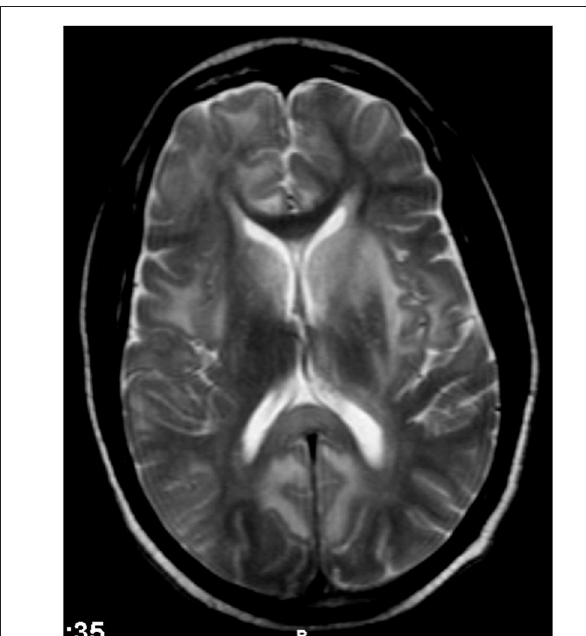
FIGURE 1 | Case 12: Brain MR imaging (axial T2-weighted image) demonstrating multiple confluent white matter hyperintensities. There are significant hyperintensities bilaterally in the caudate, partly extending into the adjacent anterior putamen but sparing the thalami. The genu of corpus callosum is strikingly spared but the splenium/posterior body shows hyperintensities.